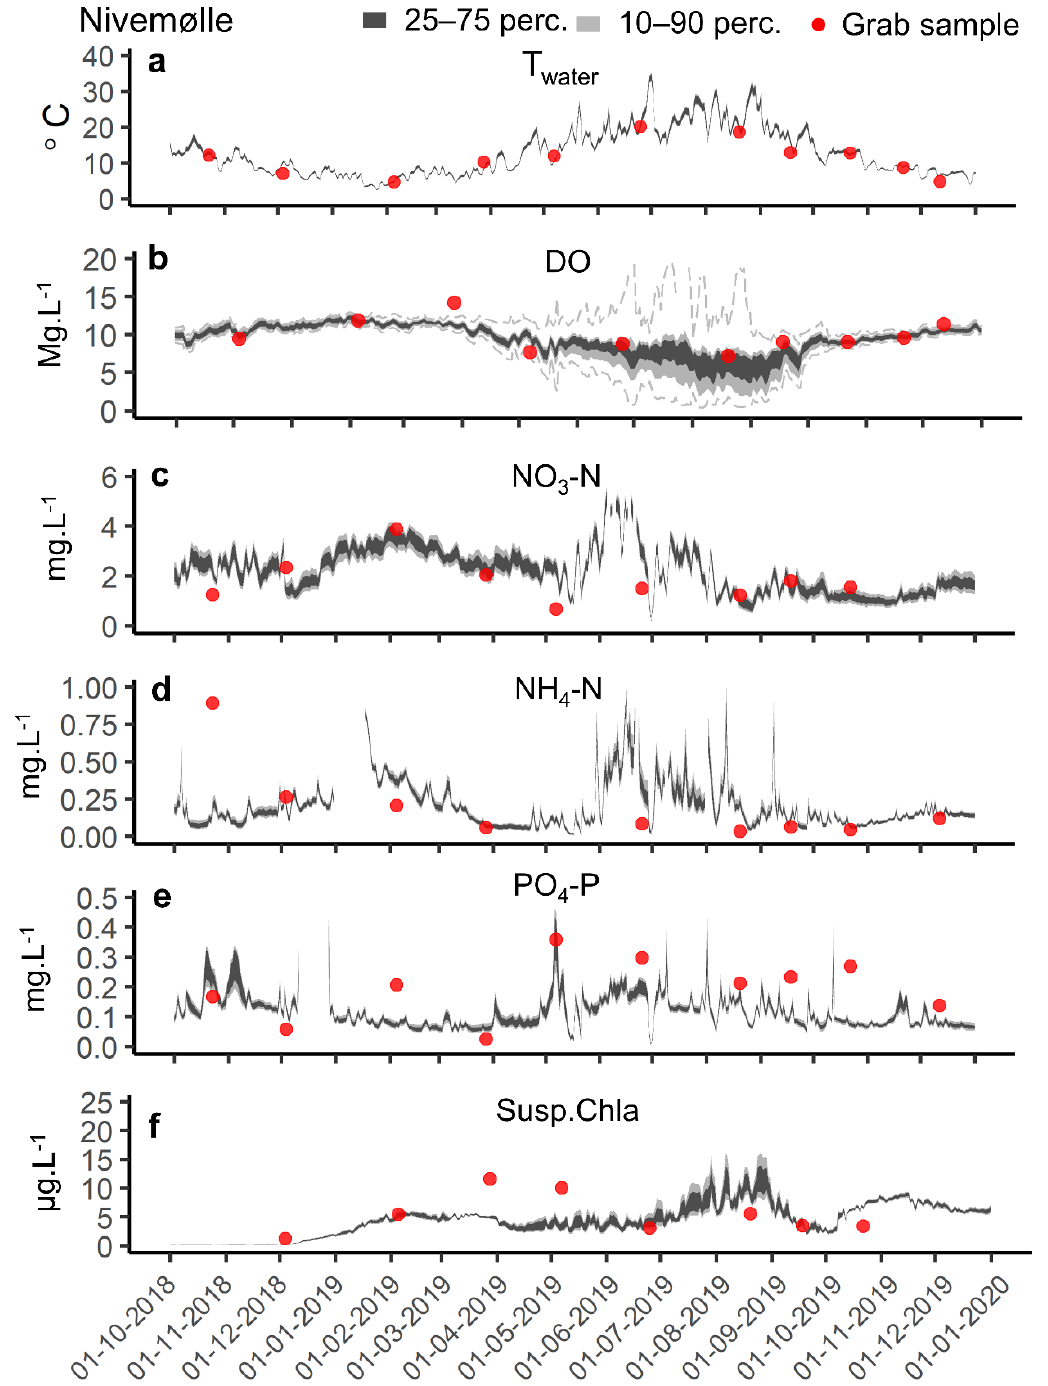
Figure 8. MC simulation results at Nivemølle. ( a ) temp; ( b ) DO; ( c ) NO 3 -N; ( d ) NH 4 -N; ( e ) PO 4 -P and ( f ) susp. chla compared to available grab sampled measurements (red circles). The dashed grey lines for the DO concentration ( b ) highlight the 10–90 percentile for the sub-daily DO variations. Results are displayed for the verification period only, with grab samples for nutrients and chla combined with simulated flow used as forcing input at the most upstream station Grønnegade and at Donse tributary (Figure S16). Parameter distributions for the MC simulation are given in Table